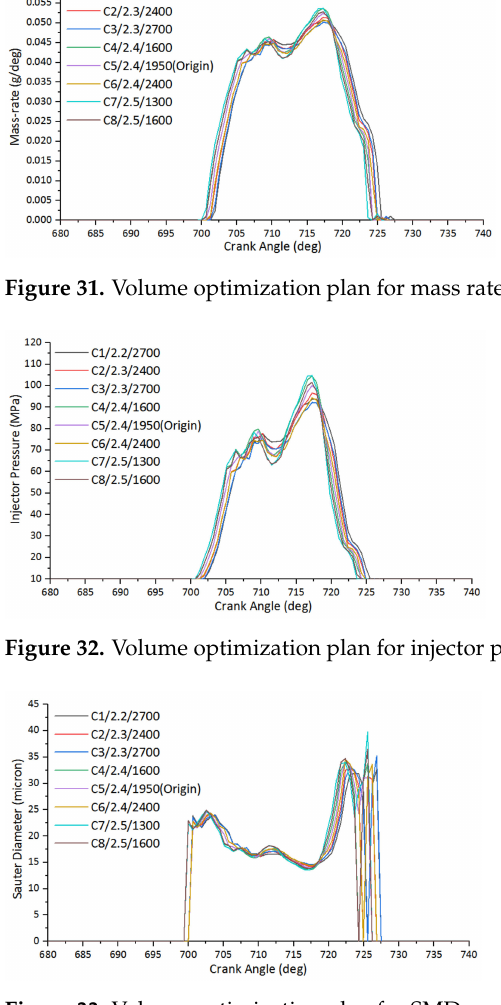
Figure 33. Volume optimization plan for SMD.